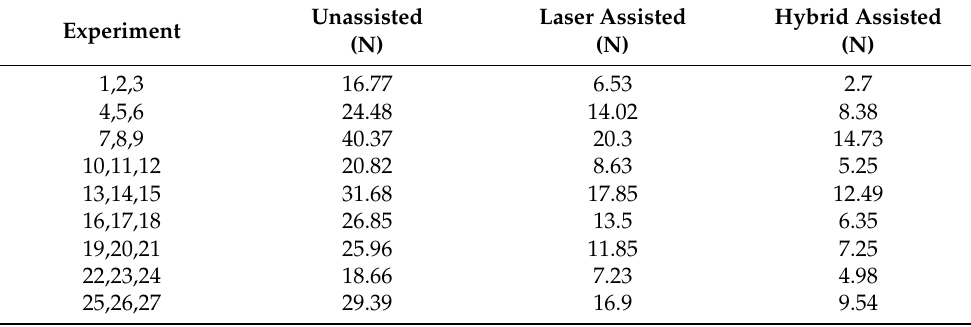
Table 7. The average cutting force values of 27 milling